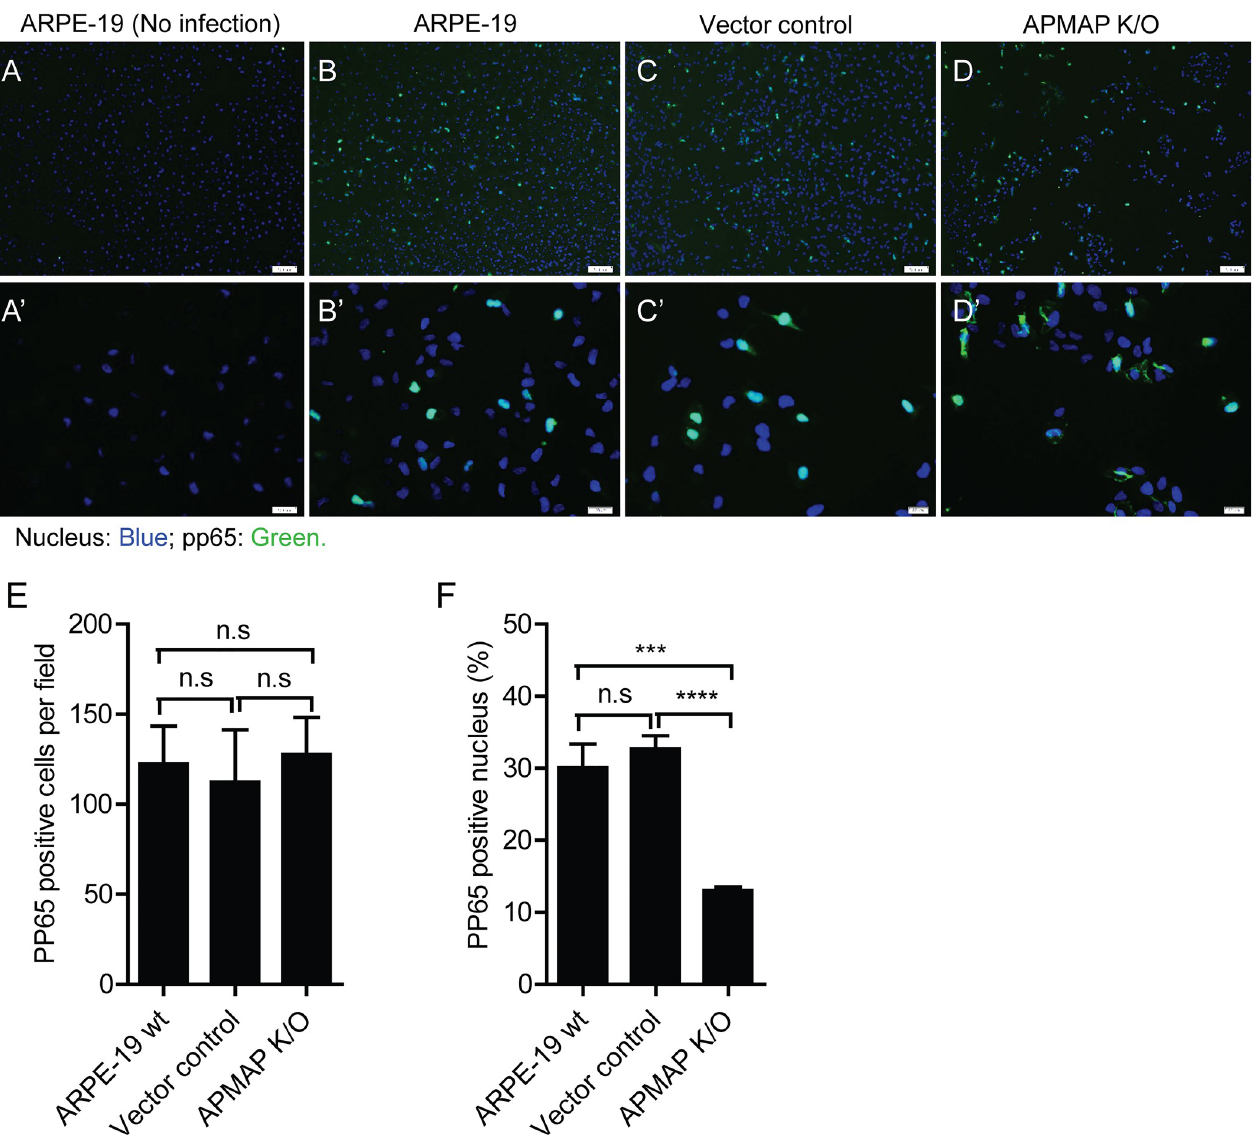
Fig 9. APMAP deficiency reduced pp65 translocation into nucleus. ( A-B, A’-B ’) Wildtype ARPE-19, ( C, C’ ) vector control and ( D, D’ ) APMAP K/O cells were seeded in chamber slides (1.5 × 10 4 cells/well) for 1 day. The cells were pre-cooled at 4˚C before adding AD169rev for attachment at 4˚C for 1 h to synchronize virus infection. Then, the cells were transferred to 37˚C and cultured for 3 h before fixation with 4% PFA. The cells were stained with mouse anti- pp65 antibodies and Alexa Fluo-488 conjugated anti-mouse IgG antibodies. Nuclei were stained by Hoechst. (A, A’) Mock-infected ARPE-19 cells were stained to serve as negative control. The images were captured using an Olympus fluorescence microscope. Panels A-D are representative images showing overall pp65 staining at lower magnification (Bar = 100 μ m). Panels A’-D’ are representative images showing pp65 staining at higher magnification (Bar = 20 μ m). ( E ) The number of pp65 positive cells were counted in four independent images for each sample as shown in panels A-D and plotted as Mean ± SD of GFP positive cells per field. ( F ) The number of pp65 positive nucleus in four independent images for each sample as shown in panels A-D were counted, respectively, and shown as percentages to the number of total pp65 positive cells in each image. Pairs of samples as indicated in the Fig 9E and 9F were compared individually using unpaired two-tailed student t-test for significance analysis. The data shown are representative results of two independent experiments.